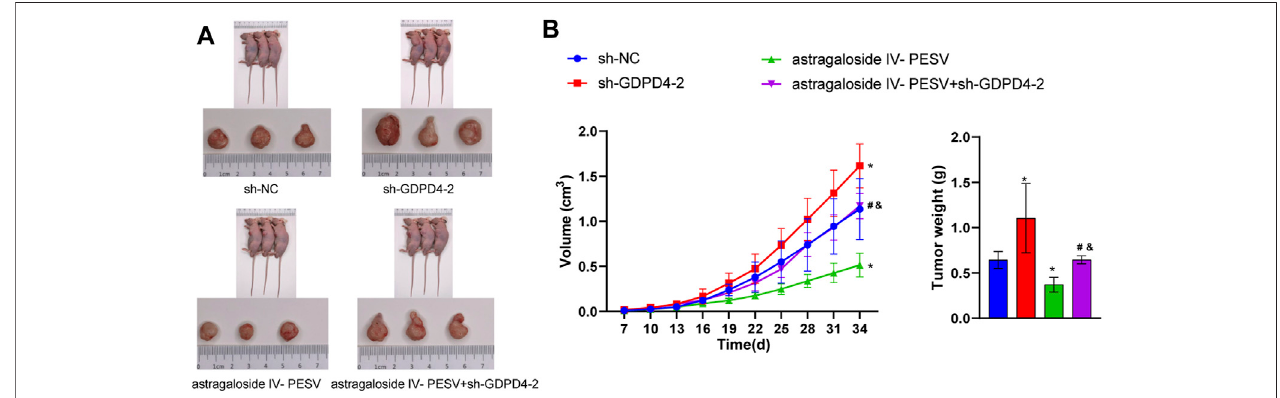
FIGURE 6 | Down-regulation of GDPD4-2 reversed the therapeutic effect of Astragaloside IV-PESV on PCa. (A) The tumor tissue of mice was observed. (B) The tumor volume and tumor weight of mice were analyzed. * p < 0.05 vs. sh-NC group, # p < 0.05 vs. sh-GDPD4-2 group, & p < 0.05 vs. Astragaloside IV-PESV group.